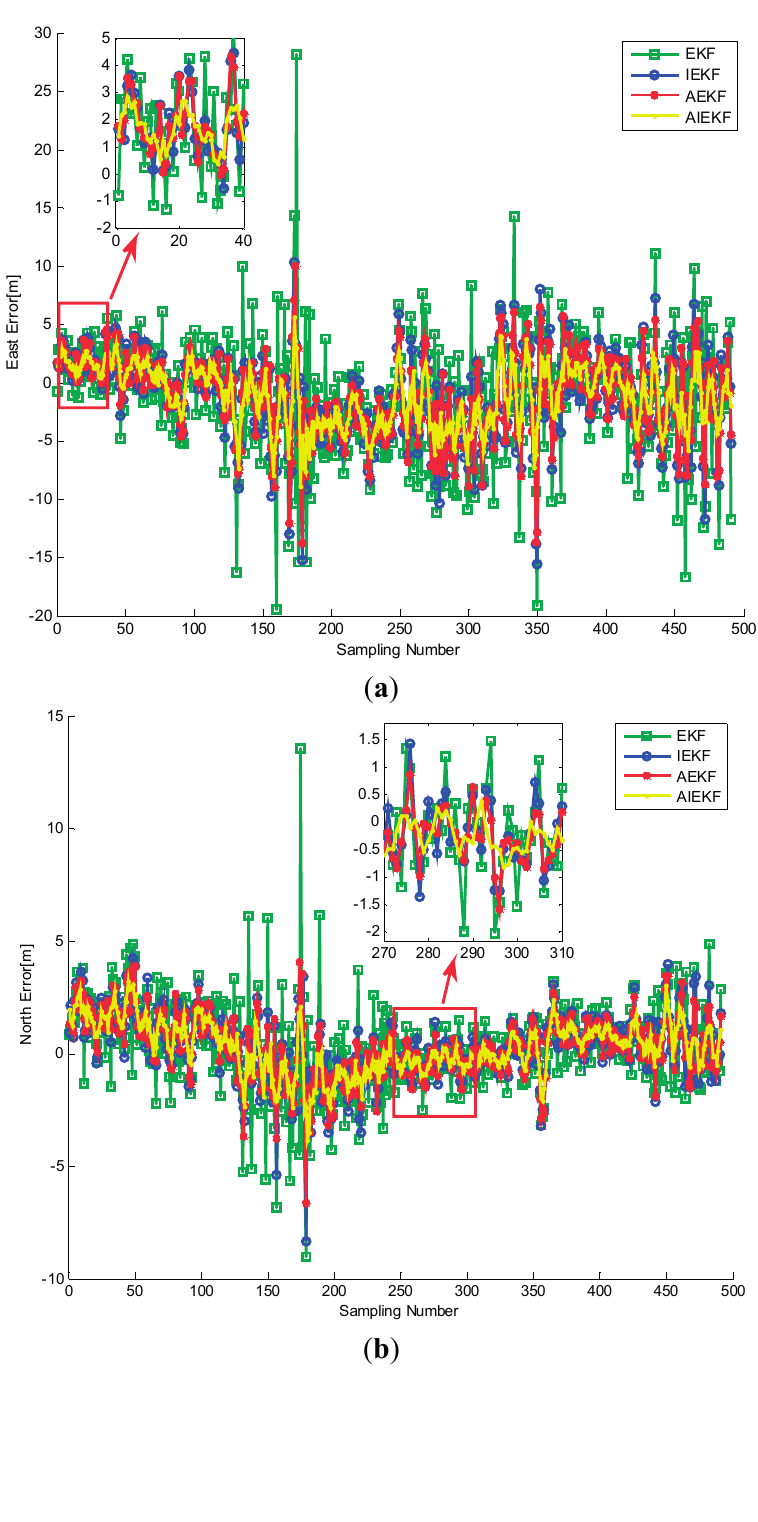
Figure 12. Position errors of VLL GPS receiver. ( a ) Longitude error; ( b ) Latitude error; ( c ) Altitude